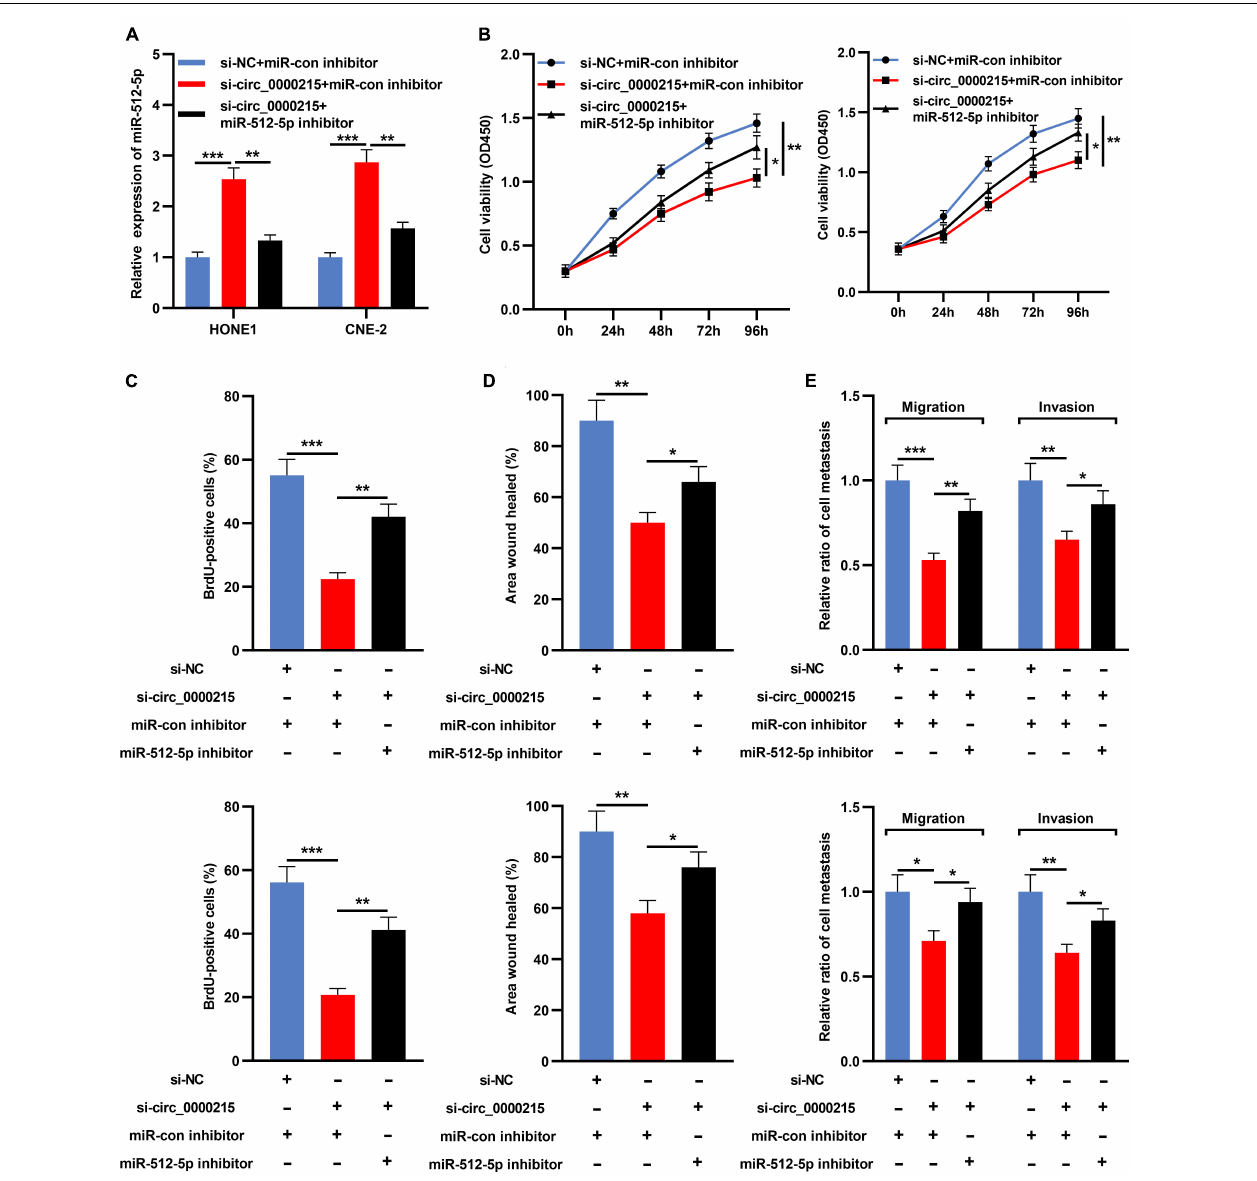
FIGURE 6 | Inhibition of miR-512-5p partially reverses the inhibitory effect of circ_0000215 knockdown on NPC cells. (A) HONE1 and CNE-2 cells were transfected with control siRNA, si-circ_0000215 or si-circ_0000215 + miR-512-5p inhibitor, and then miR-512-5p expression was detected by qRT-PCR. (B) CCK-8 experiment was executed to detect the viability of HONE1 and CNE-2 cells after the transfection. (C) BrdU assay was employed to detect the proliferation of HONE1 and CNE-2 cells after the transfection. (D) Wound-healing assay was utilized to detect the motility of HONE1 and CNE-2 cells after the transfection. (E) Transwell assay was performed to detect the migration and invasion of HONE1 and CNE-2 cells after the transfection. The significance of difference was determined by Student’s t -test or one-way ANOVA.* P < 0.05, ** P < 0.01, and *** P < 0.001. Data from three independent experiments were expressed as mean ± standard deviation.